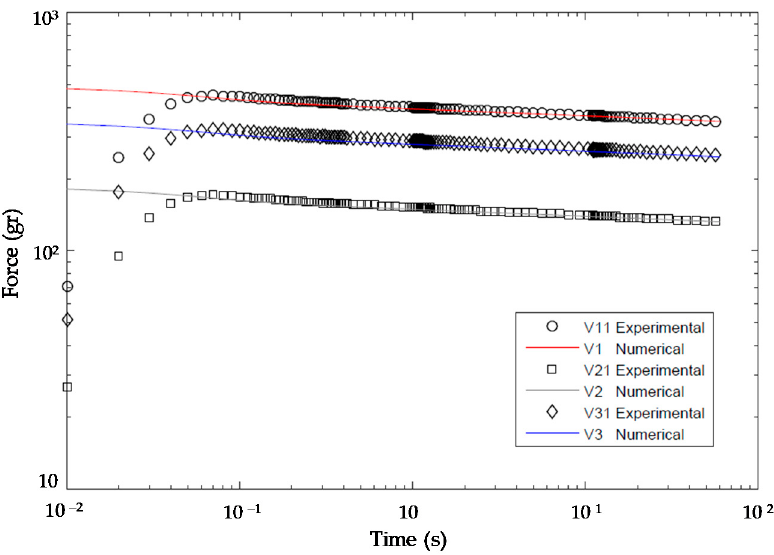
Figure 12. Comparison between the experimental forces and those obtained from viscoelastic FEA.